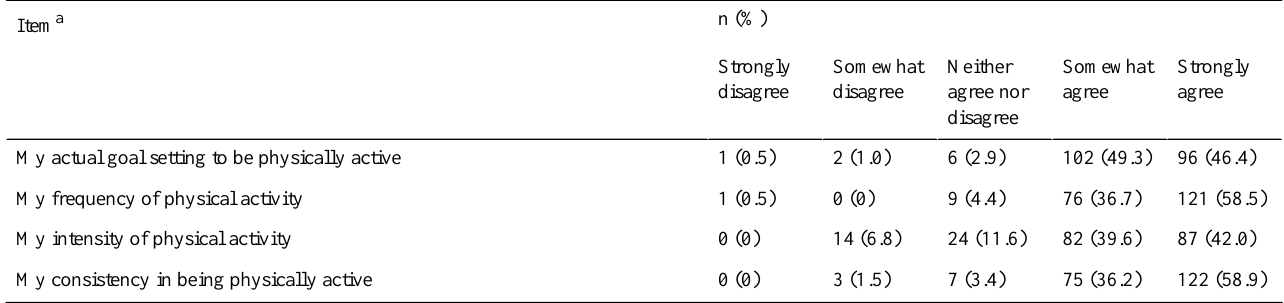
Table 4. Responses to physical activity behavior items (N=207). A composite behavior change variable was computed by summing these variables, Cronbach alpha=.854.